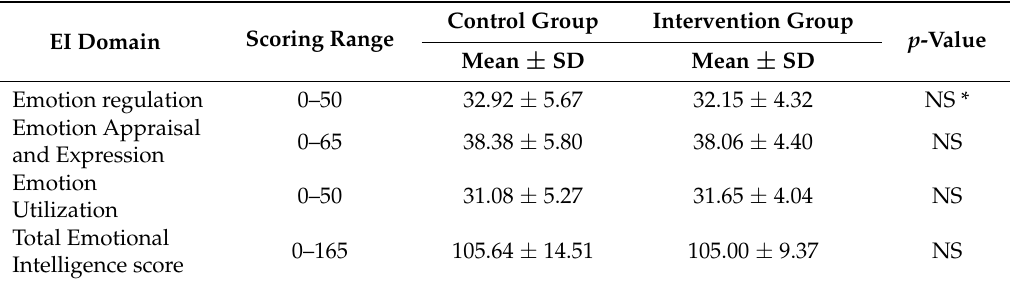
Table 1. Emotional Intelligence comparison between intervention and control group (before intervention) just after the intervention.